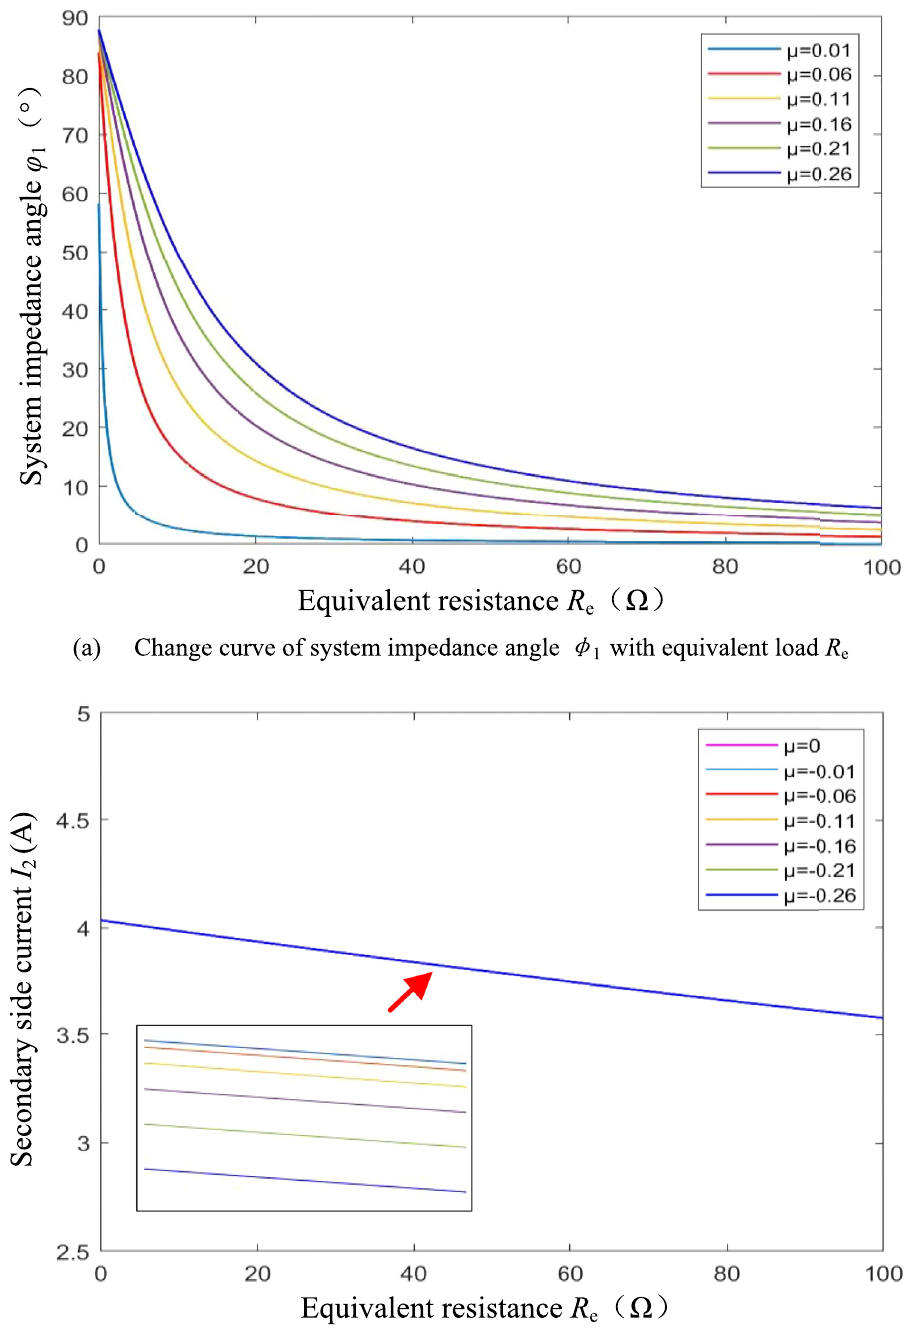
Figure 4. System impedance angle and secondary current when the secondary side is